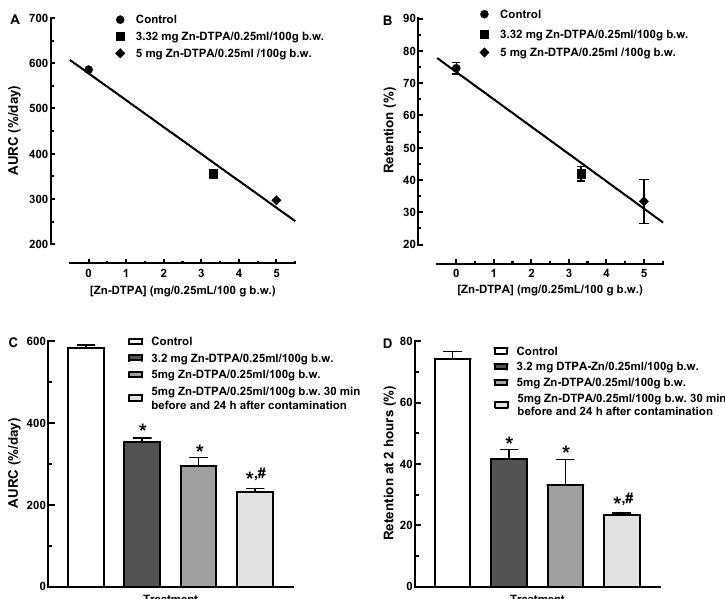
Figure 3. Dose-dependence of 65 Zn decorporation on Zn-DTPA. ( A ) Linear-dependence of 65 Zn area under the retention curve (AURC) on Zn-DTPA dose. ( B ) Linear-dependence of 65 Zn retention on Zn-DTPA dose at two days post contamination. ( C ) Comparison of 65 Zn AURC on Zn-DTPA treatments. ( D ) Comparison of the 65 Zn retention on Zn-DTPA treatments at two days post contamination. Data represent means ± SEM ( n = 7). Statistically significant difference compared to control (*) and low-dose Zn-DTPA (#), p < 0.05, one-way ANOVA.